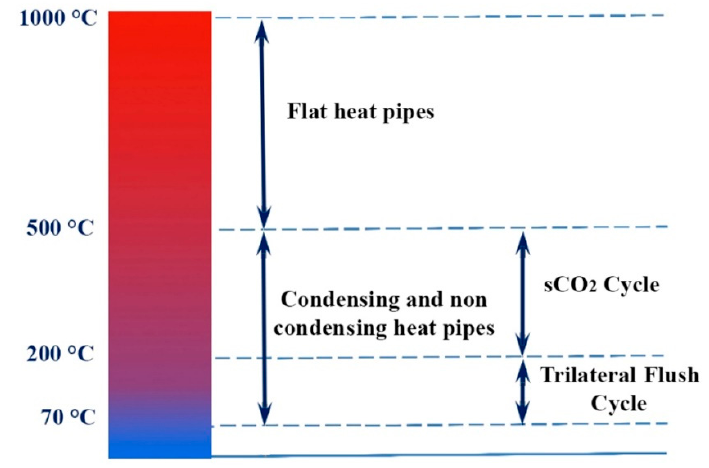
Figure 1. Heat recovery range and technologies in I-ThERM.